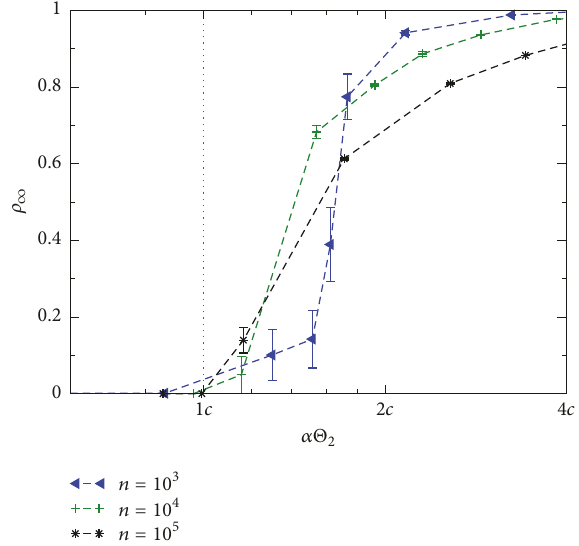
Figure 3: Coordination game with PI dynamics for scale-free networks (with 𝛾 = 2.5 , 𝑘 min = 3 , and 𝑘 max = √𝑛 ): stationary cooperation levels 𝜌 ∞ versus 𝛼Θ 2 for various system sizes 𝑛 . The vertical solid line identifies the critical value of 𝛼 𝑐 Θ 2 = 𝑐